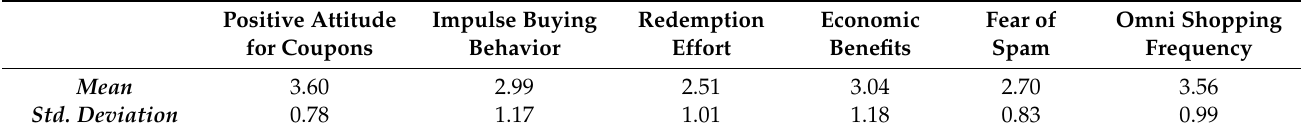
Table 2. Descriptive Statistics for Concomitant Variables (5-point Interval Scale).